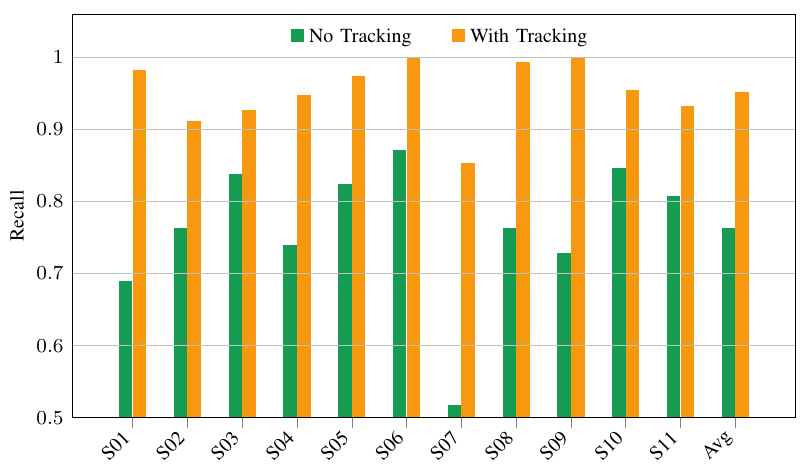
Figure 6. Impact of Tracking on Precision of Face Recognition. Fig. 1. Impact of Tracking on Precision of the Proposed Framework.